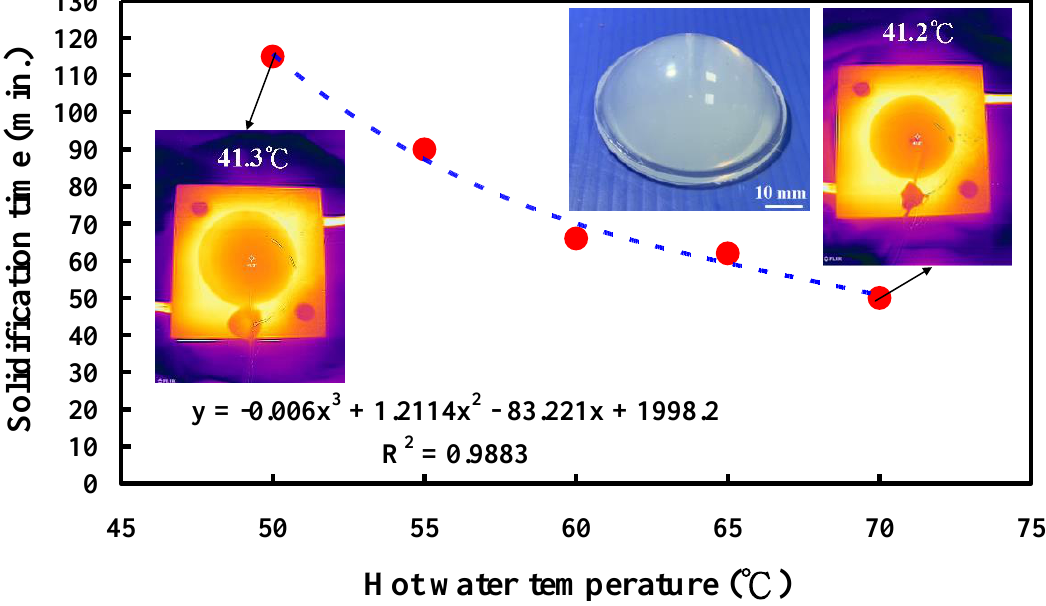
Figure 10. Solidification time of a convex lens for different vulcanizing hot-water temperatures.